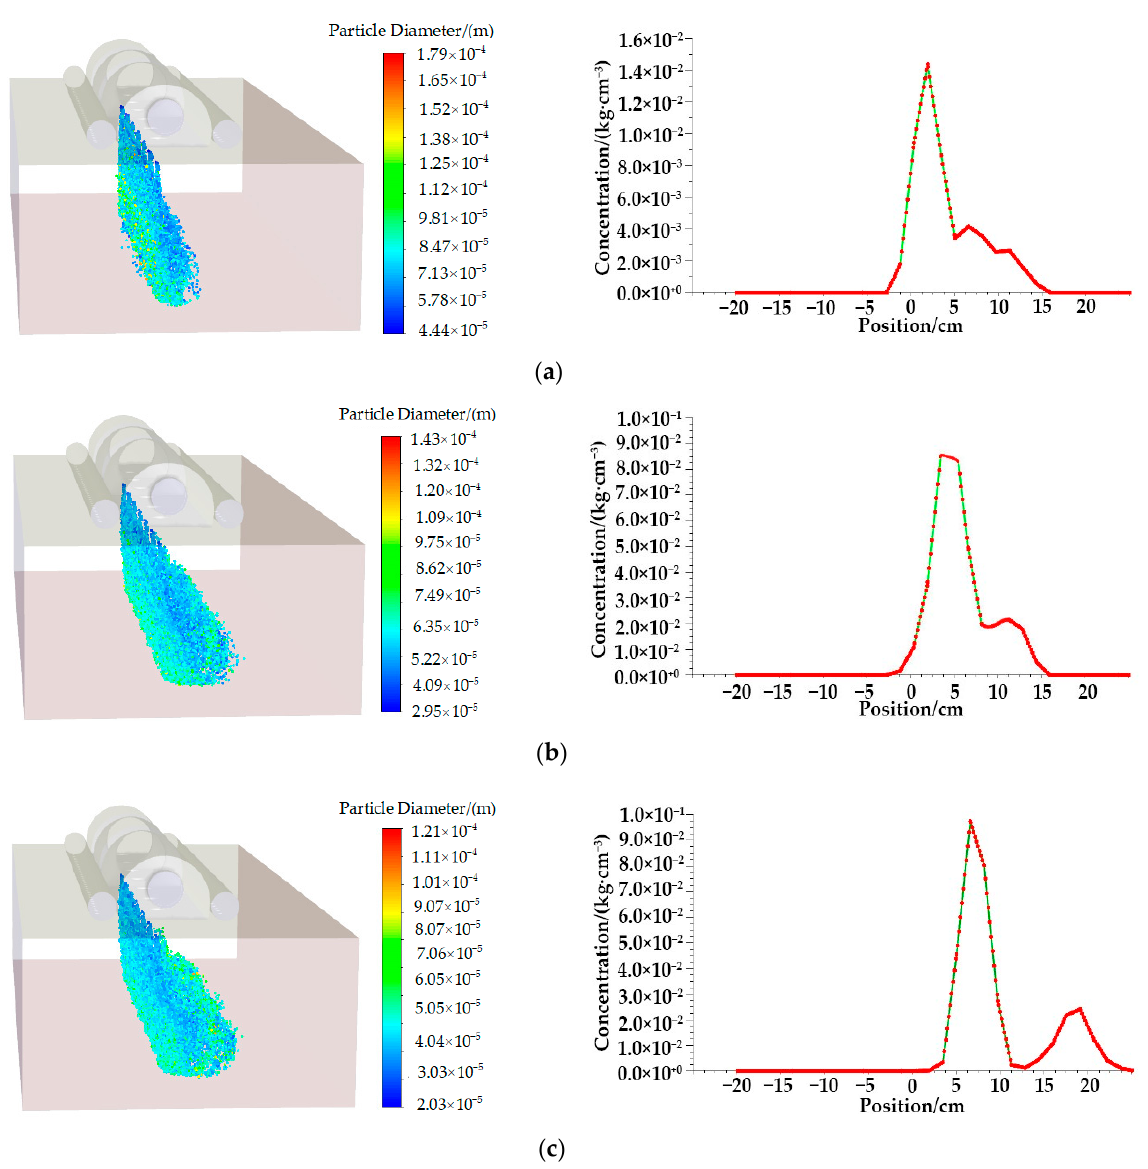
Figure 13. Droplet spatial distribution and the droplet concentration in the calibration line with different spray pressure: 0.4 MPa ( a ); 0.5 MPa ( b ); 0.6 MPa ( c ).